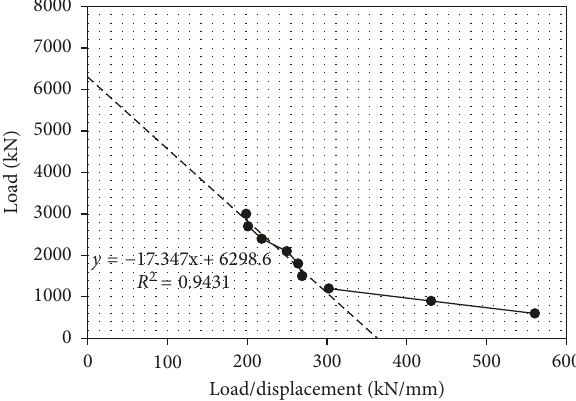
Figure 11: Uplift SLT result of